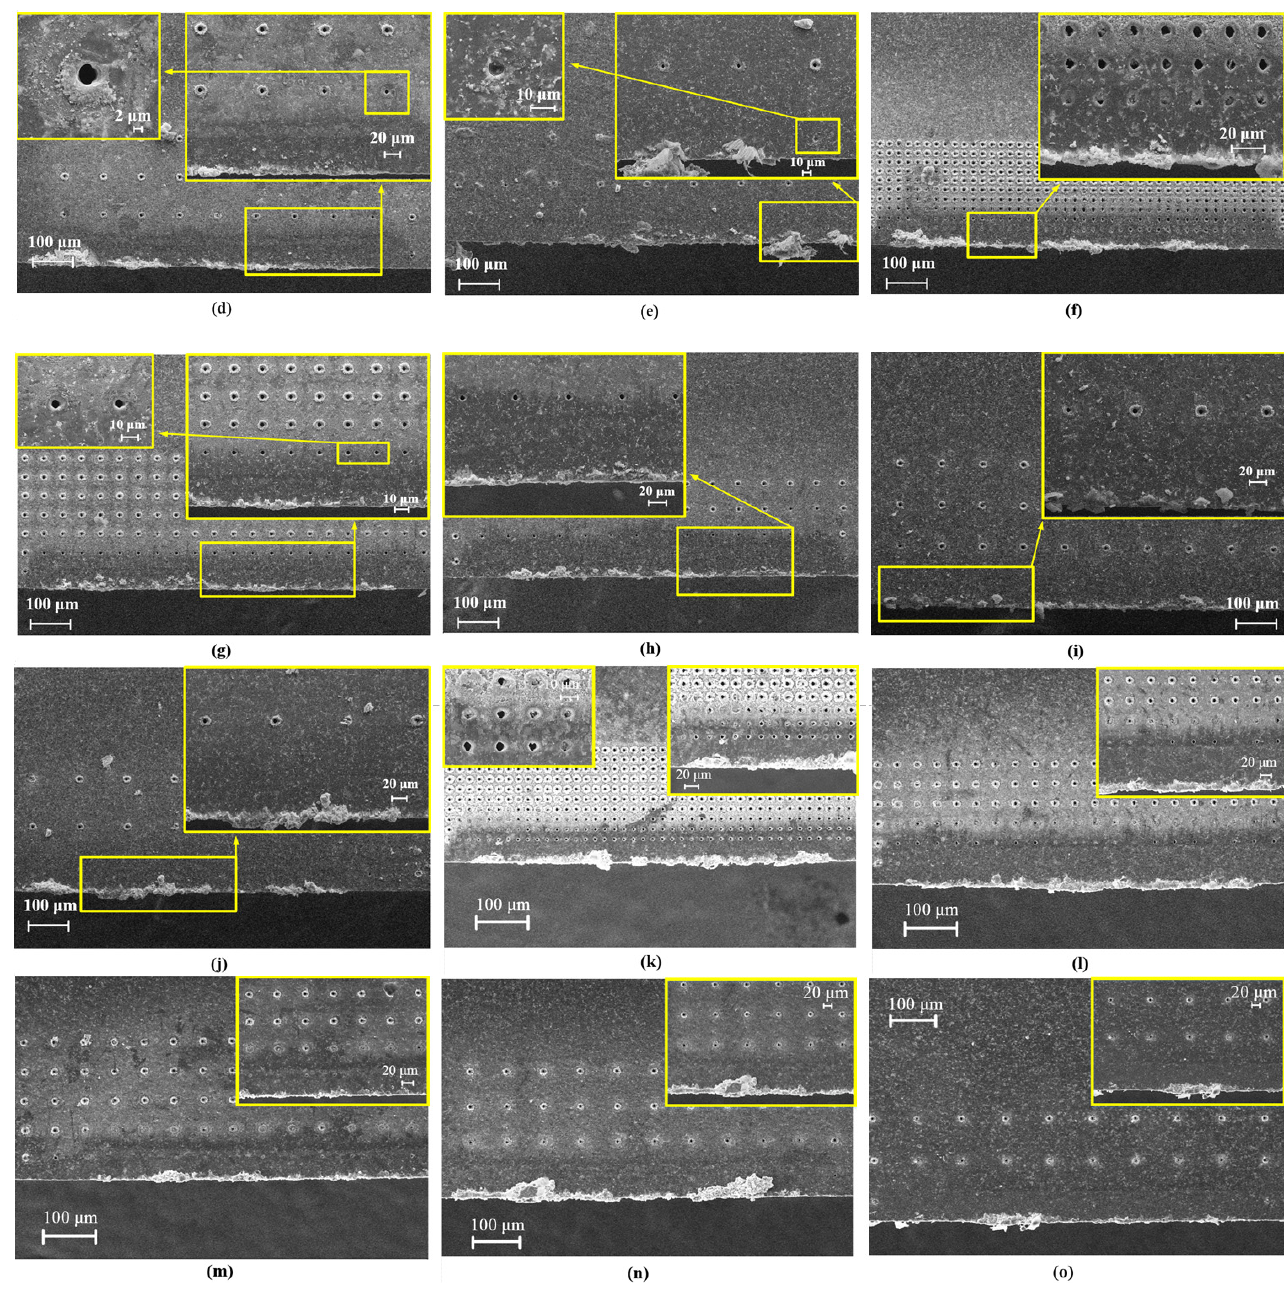
Figure 8. SEM images of micro-pit-textured PCD tool surface after orthogonal cutting. ( a – o ) Corre- spond to Tools 2 to 16.